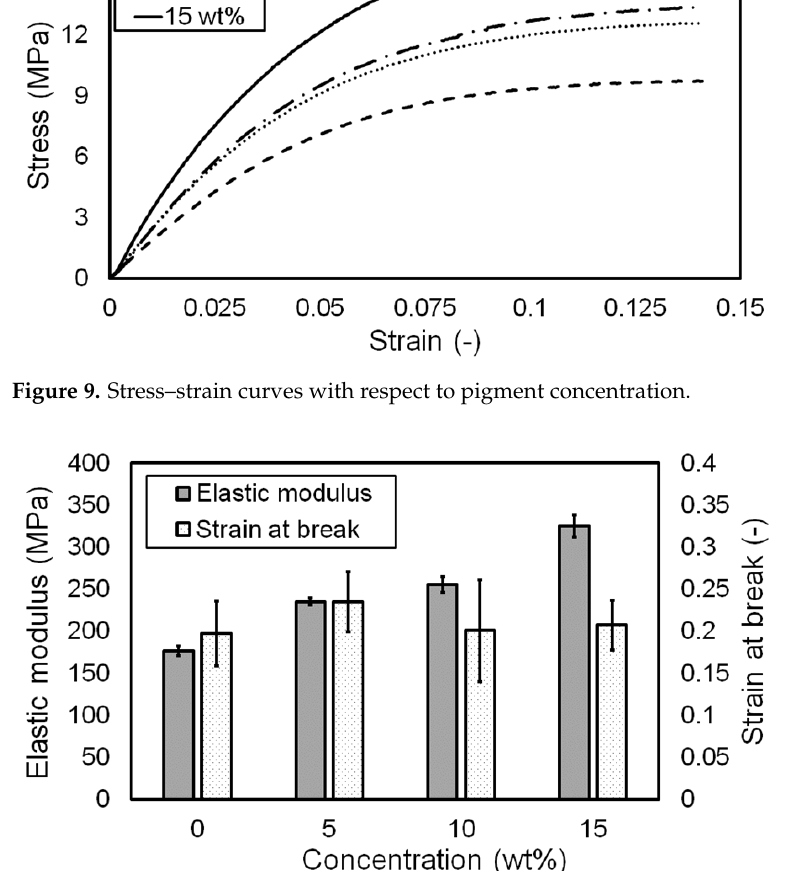
Table 2. Elastic modulus and strain at break with respect to dye concentration.